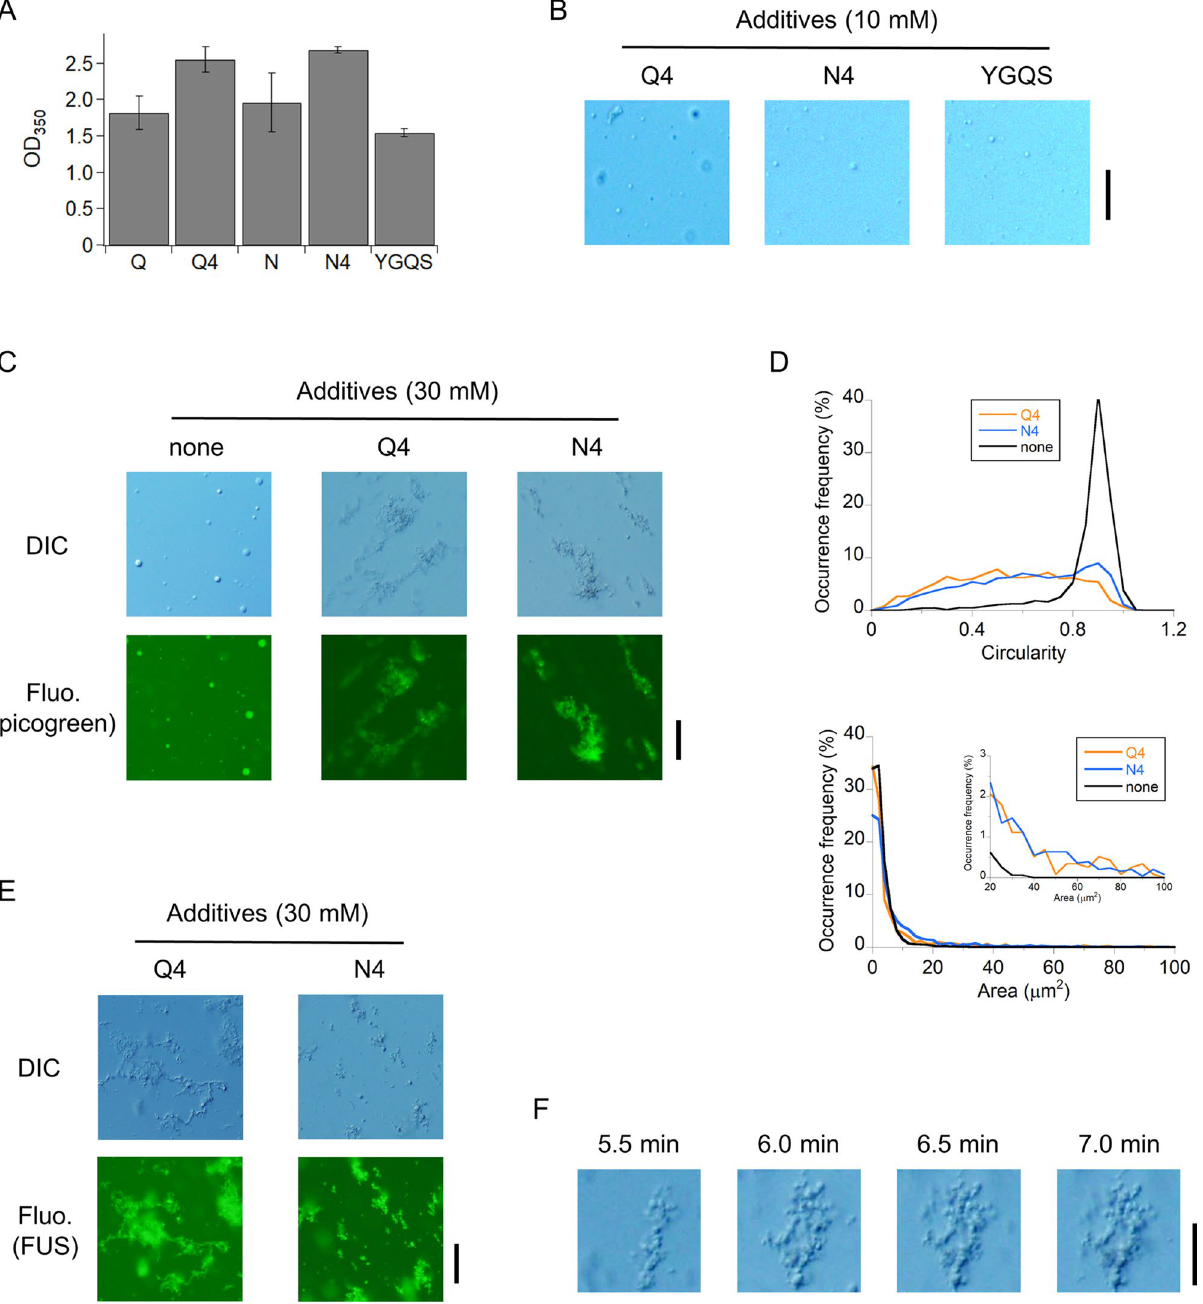
Figure 5. QQQQ and NNNN additives converted droplets of FUS into aggregates. ( A ) Effect of 4-mer peptides on droplets of MBP-FUS detected as the scattering at 350 nm (low concentrations). The solution contained 5 µM MBP-FUS plus 40 mM Gln or Asn or 10 mM 4-mer peptides in 140 mM KCl and 80 mg/mL dextran. Error bars represent the standard errors ( N = 3). ( B ) DIC images of MBP-FUS solutions in the presence of 4-mer peptides at low concentrations. The solution conditions were the same as in ( A ). Scale bar denotes 10 µm. ( C ) DIC and fluorescence images of MBP-FUS solution in the presence/absence of Q4 or N4 at high concentrations. The solution contained 15 µM MBP-FUS plus 30 mM Q4 or N4 in 183 mM KCl and 65 mg/mL dextran. Scale bar denotes 10 µm. The fluorescence of amyloid-sensitive PicoGreen was detected. None denotes the absence of additives. Scale bar denotes 20 µm. ( D ) Distributions of cross-section area and circularity of individual droplets or aggregates of MBP-FUS in the DIC images in the presence of Q4 ( N = 1170) or N4 ( N = 2528) at high concentrations or in the absence of the additives ( N = 3419). The solution conditions were the same as in ( C ). ( E ) Uptake of MBP-FUS into the aggregates evaluated using DIC and fluorescence microscopy; 0.1 µM MBP-FUS-Alexa488 was added to a solution of non- labeled MBP-FUS, as described in ( C ). Scale bar denotes 20 µm. ( F ) Time-lapse DIC images for aggregate formation of MBP-FUS in the presence of N4 at high concentrations. The time after mixing MBP-FUS and N4 is displayed. The solution conditions were the same as in ( C ). Scale bar denotes 10